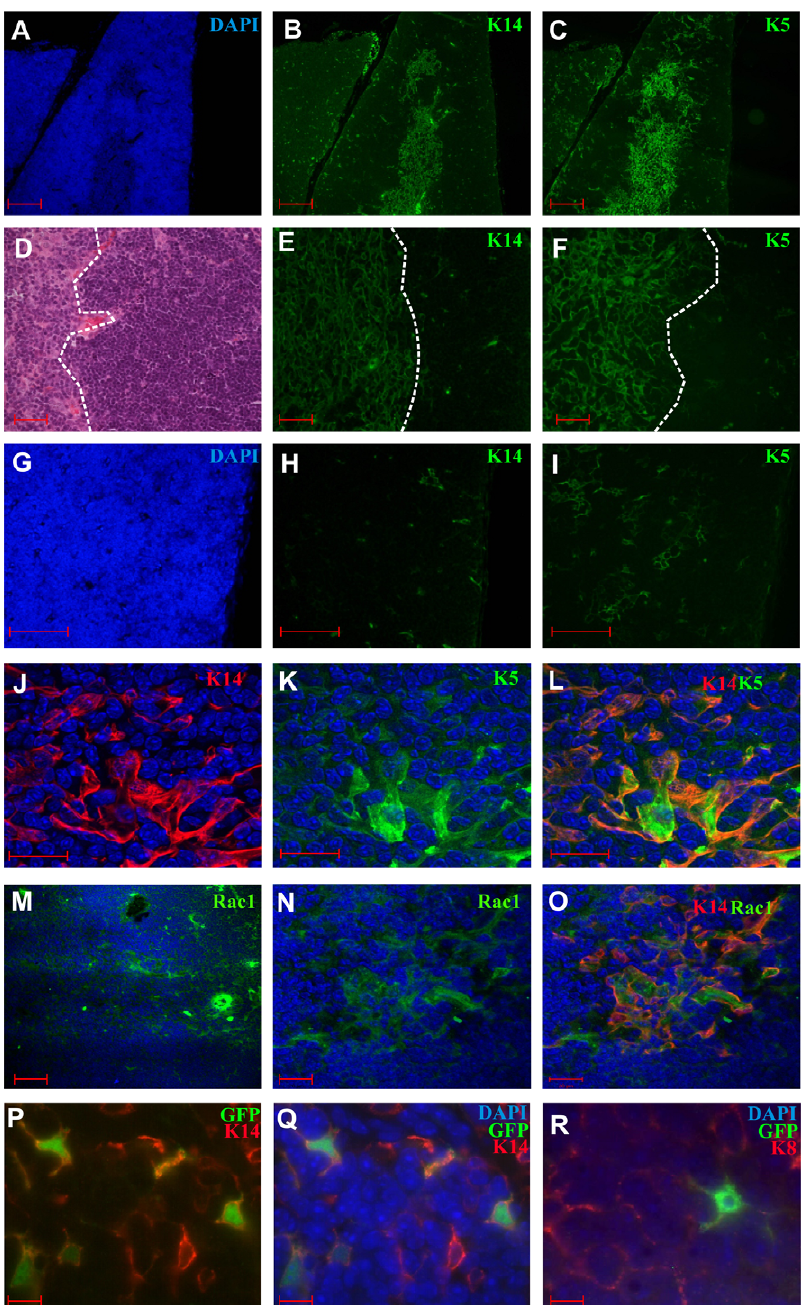
Figure 1. Keratin and Rac1 expression in the thymus. (A–F and J–L) K14 and K5 largely co-localise in medullary epithelium; dotted lines in D–F denote medullary-cortical boundary. (G–I) Thymic cortex with scattered K14 and K5 positive cells. (M–O) Rac1 staining is widespread in the thymus (epithelial cells and thymocytes (M)) but the brightest Rac1 staining co-localises with K14 positive epithelial cells of the medulla, (N and O). (P and Q) demonstrate K14 positive epithelial cells that are GFP positive in K14 lineage tracing analysis, but no GFP positive cells in the K8 stained cells (R). Scale bars (A–C) 100 m m, (D–I, M and R) 50 m m, (J–L, N and O) 20 m m, (P–R) 5 m m.